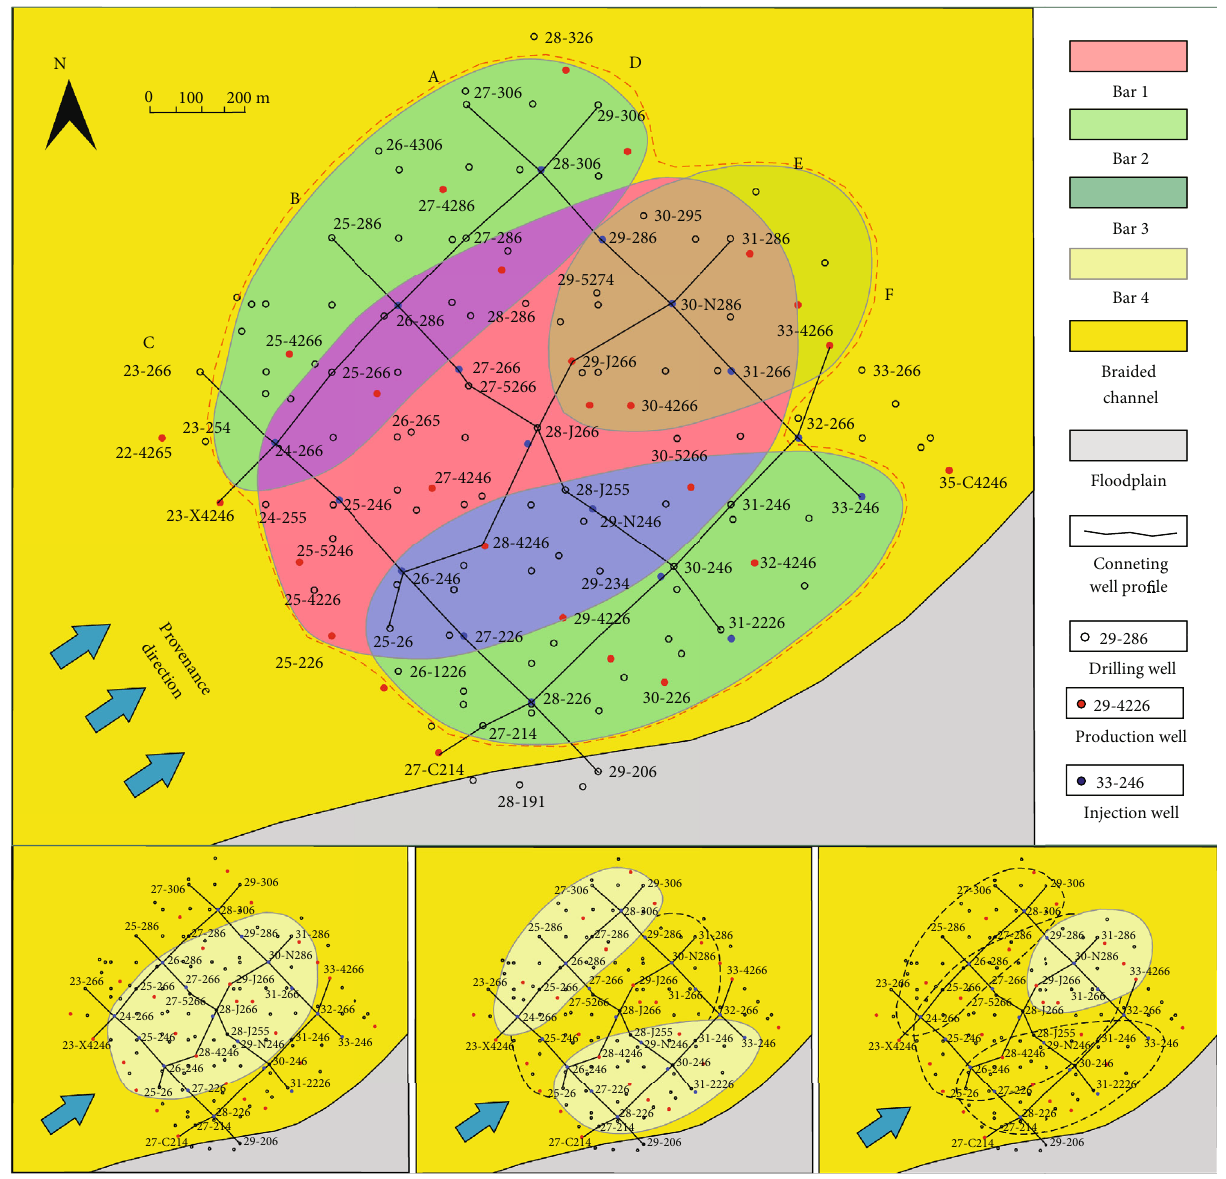
Figure 8: Planar distribution of single midchannel